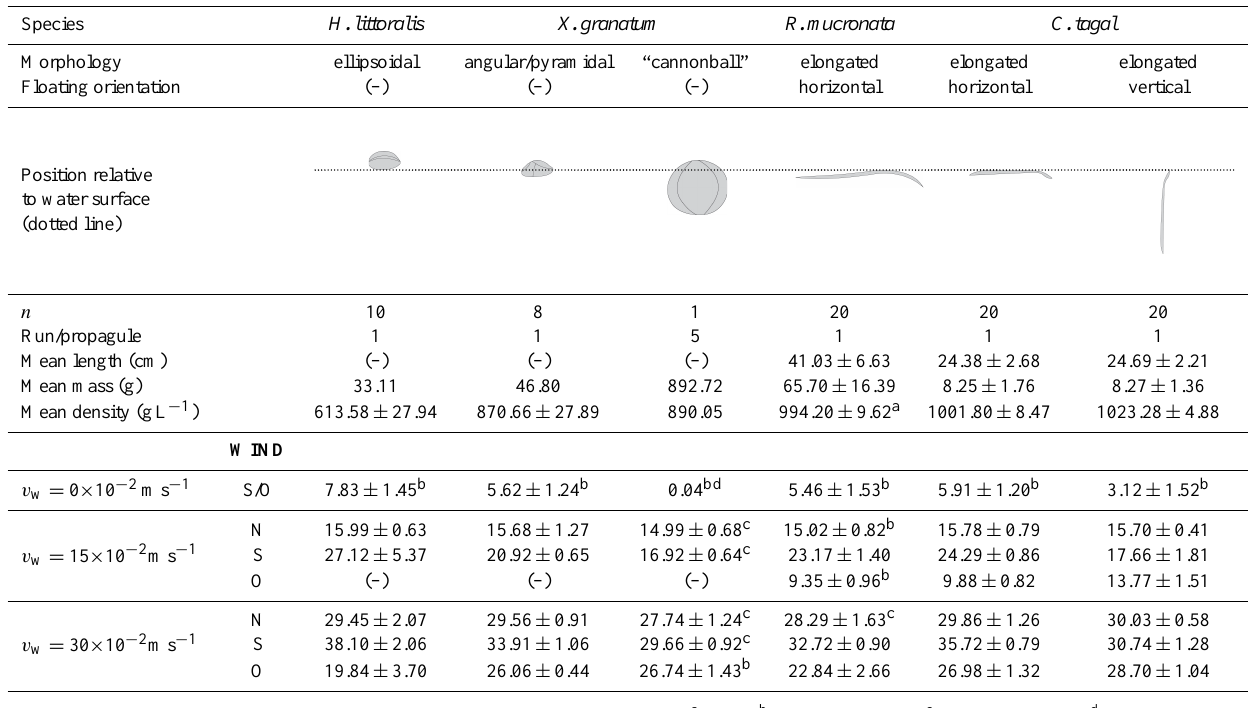
Table 1. Propagule characteristics and dispersal speed under various hydrodynamic and wind conditions. All values × 10 − 2 ms − 1 .